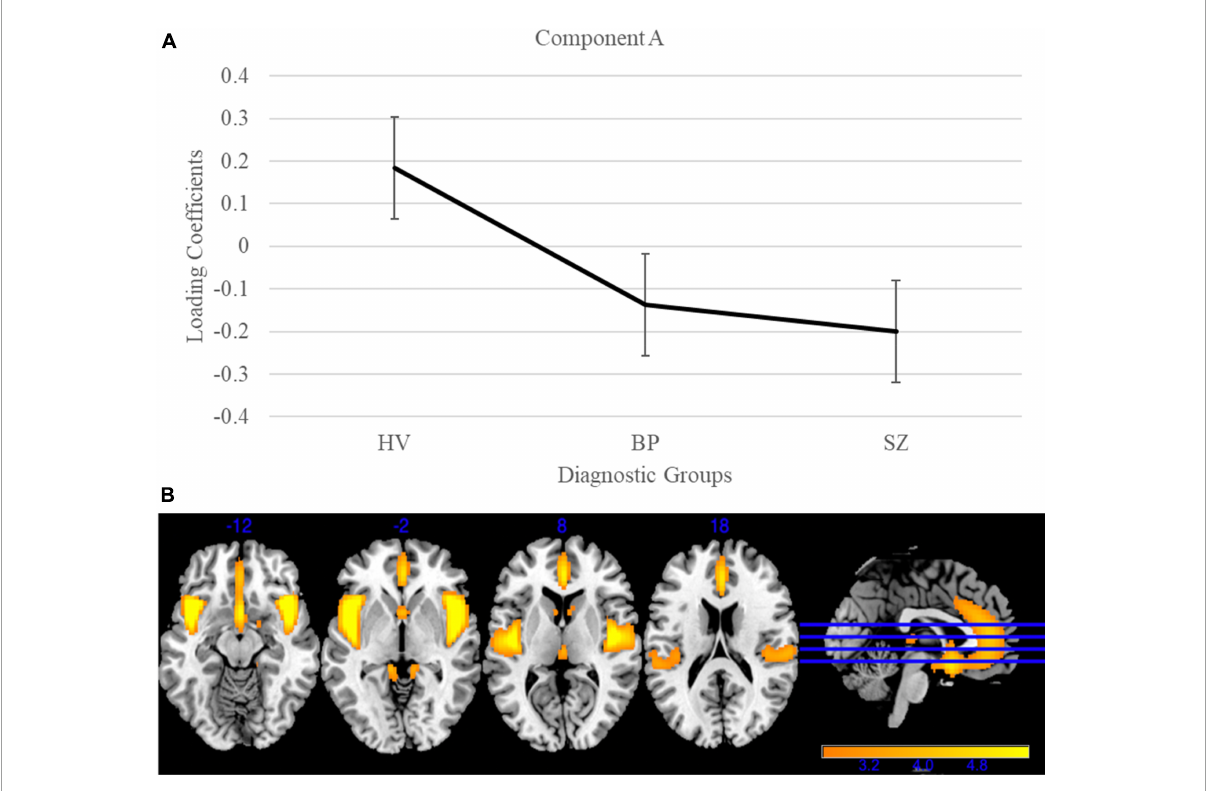
FIGURE1 Gray matter group differences in independent component analysis (ICA) results for healthy volunteers, individuals with schizophrenia, and individuals with bipolar I disorder. (A) Group effects of diagnosis on loading coefficients for Component A. Schizophrenia (SZ) and bipolar disorder (BP) had significantly less gray matter when compared to healthy volunteers but did not differ significantly from each other. (B) Component A showed less gray matter concentration in the bilateral insula and cingulate gyrus in individuals with SZ and individuals with BP compared to healthy volunteers. Images are thresholded at